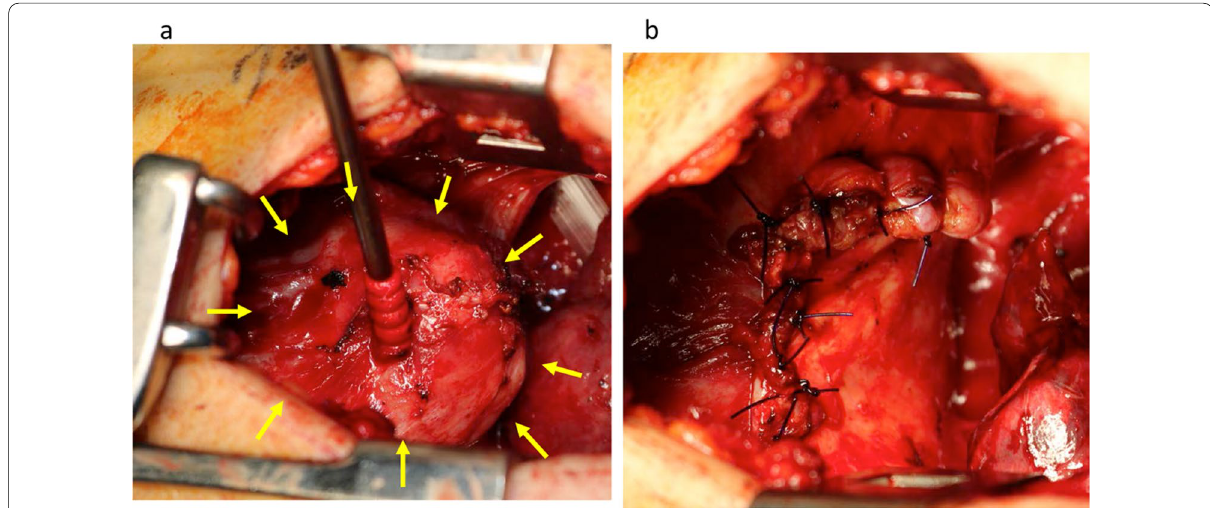
Fig. 2 Intraoperative findings. a 68-mm mass was present in the diaphragm. b We resected the mass with a healthy diaphragm margin and reconstructed the diaphragm by simple